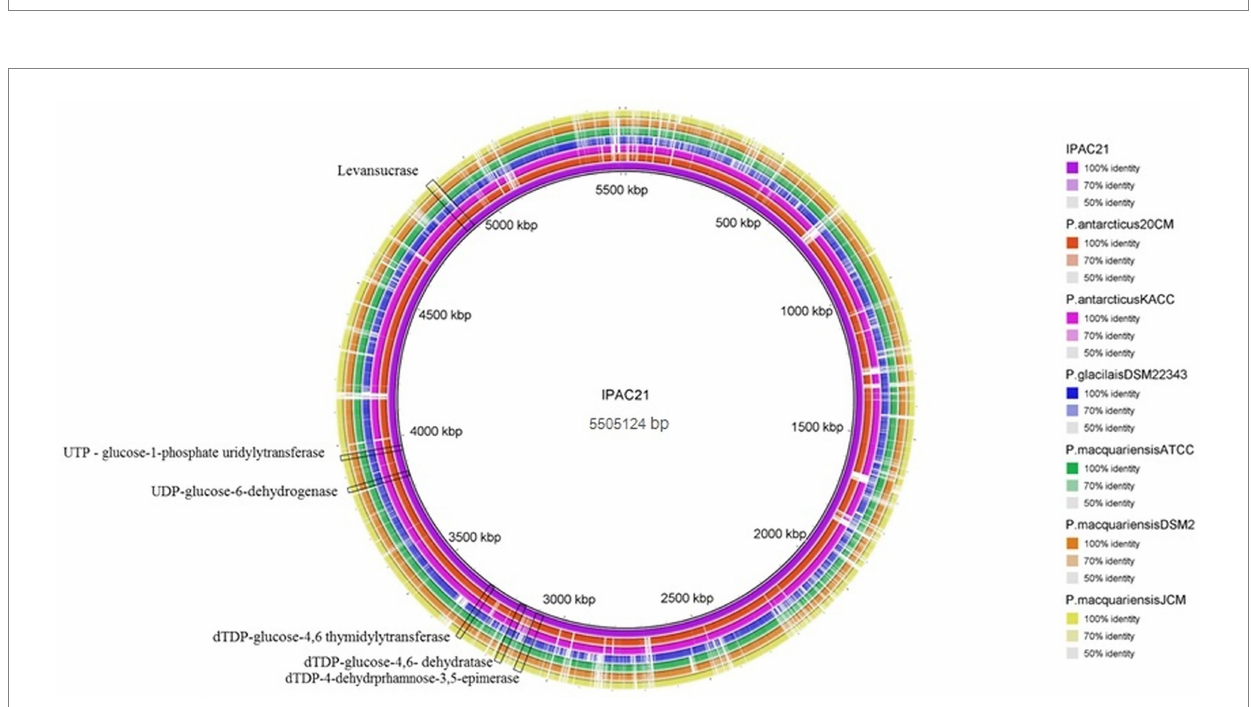
FIGURE 4 Circular diagram illustrating the nucleotide similarity between P. antarcticus IPAC21 (in purple, inside the circle) and other Paenibacillus genomes represented by concentric